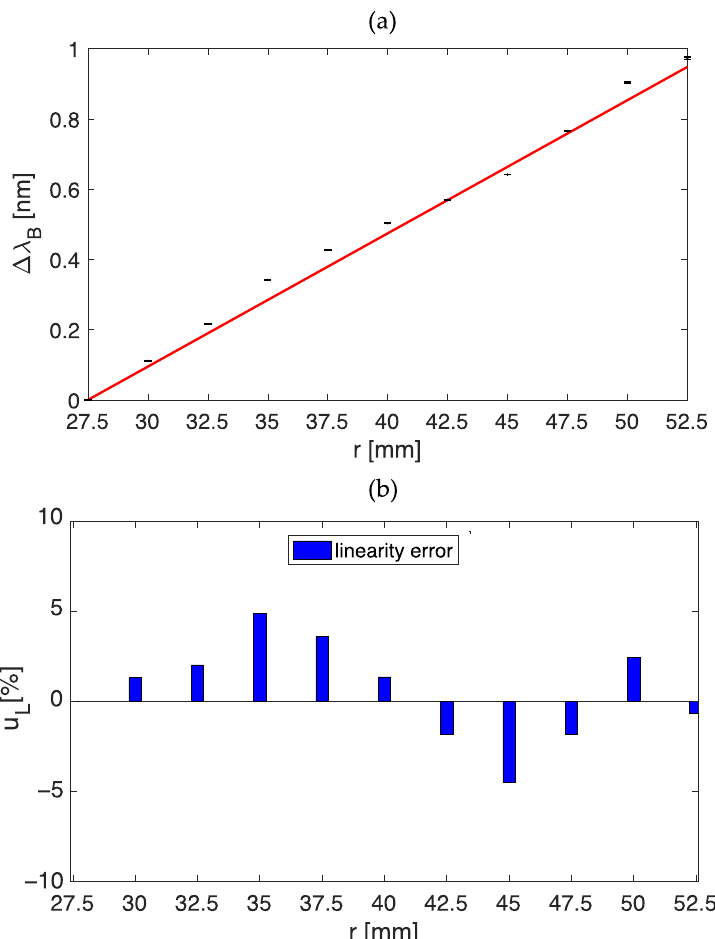
Sensors 2023 , 23 , x FOR PEER REVIEW Figure 6. The calibration curve λ B vs. r ( a ), and the bar plot of the linearity error u L ( b ). Figure 6. The calibration curve  λ B vs. r ( a ), and the bar plot of the linearity error u L ( b ).